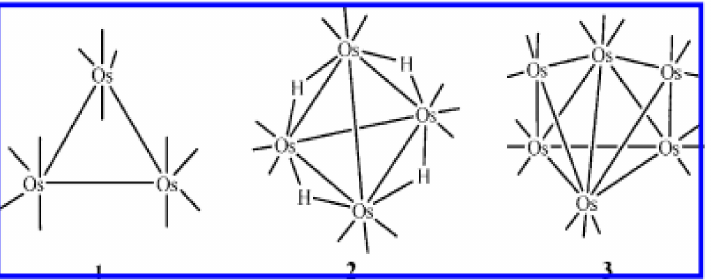
Figure 3. Schematic representation of the structures of Os 3 (CO) 12 ( 1 ), Os4-( µ -H) 4 (CO) 12 ( 2 ), and Os 6 (CO) 18 ( 3 ). Adapted from reference